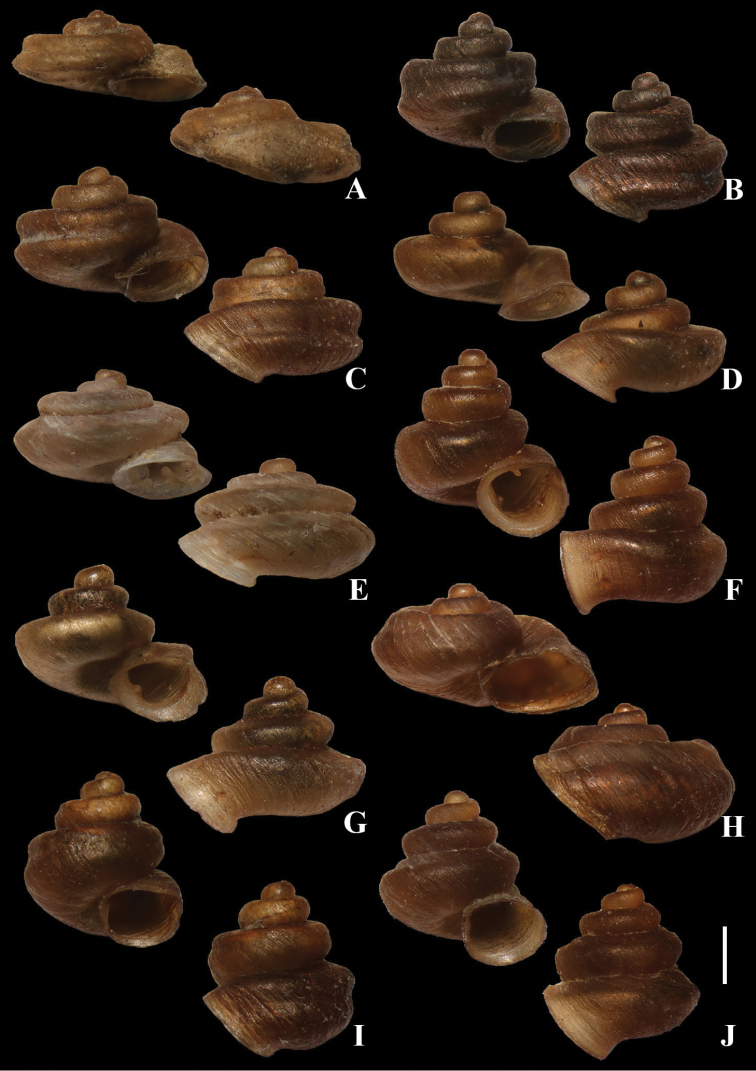
Synoptic view of Aulacospira Möllendorff, 1890 in Thailand AA.
depressaBA.
khaoboteCA.
khaopratunDA.
lampangensisEA.
panhai. FA.
pluangtongGA.
smaesarnensisHAulacospira
nutadhirai sp. nov. IAulacospira
tekavongae sp. nov. JAulacospira
vanwalleghemi sp. nov. Scale bars: 1 mm.